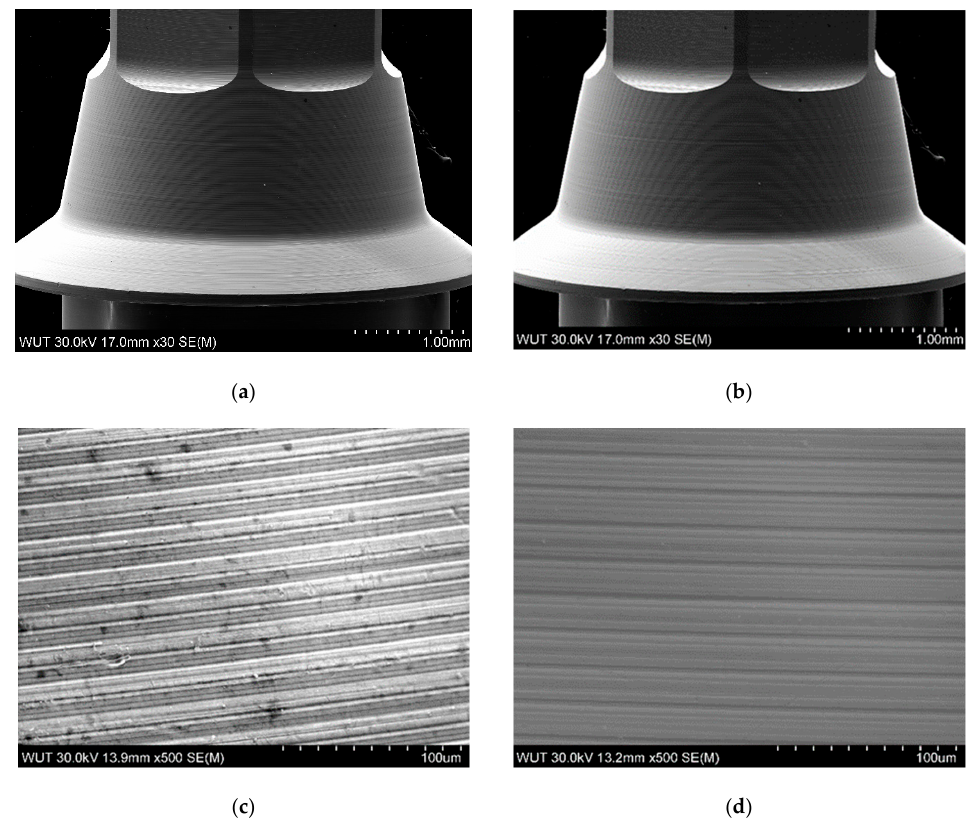
Figure 6. Test ( a , c ) and control ( b , d ) TBAs at 30× ( a , b ) and 500× ( c , d ).